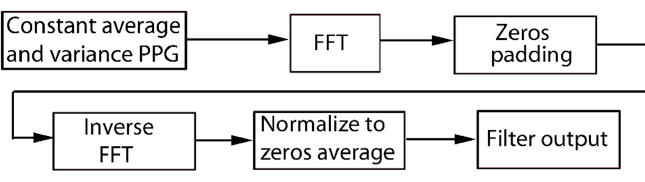
Figure 6. The block diagram of signal fast Fourier transform (FFT) filtering algorithm.